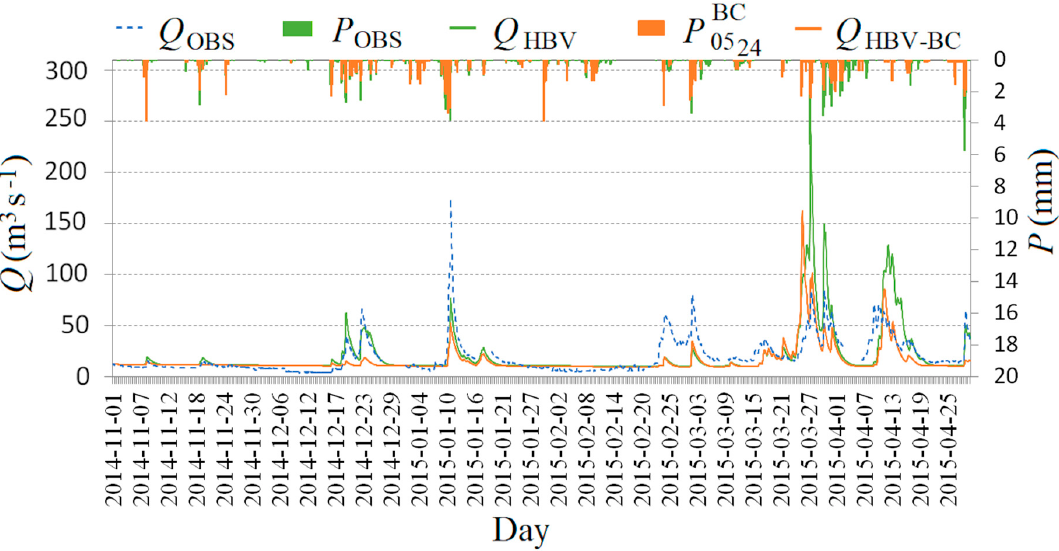
Figure 5. The comparison of Q OBS (observed flow; blue dotted line), Q HBV (HBV product for P OBS ; Figure 5. The comparison of 𝑄 (cid:2899)(cid:2886)(cid:2903) (observed flow; blue dotted line), 𝑄 (cid:2892)(cid:2886)(cid:2906) (HBV product for 𝑃 (cid:2899)(cid:2886)(cid:2903) ; green solid line), Q HBV − BC (HBV product for P BC without assimilation; solid orange line), and P OBS (cid:2886)(cid:2887) without assimilation; solid orange line), and 𝑃 05 24 green solid line), 𝑄 (cid:2892)(cid:2886)(cid:2906)(cid:2879)(cid:2886)(cid:2887) (HBV product for 𝑃 (cid:2868)(cid:2873) Figure 5. The comparison of 𝑄 (cid:2899)(cid:2886)(cid:2903) (observed flow; blue dotted line), 𝑄 (cid:2892)(cid:2886)(cid:2906) (HBV product for 𝑃 (cid:2899)(cid:2886)(cid:2903) ; (cid:3118)(cid:3120) (green bar), with P BC (orange bar) in the Sola basin at Zywiec in the winter period from 06:00H 1 (cid:2886)(cid:2887) (orange bar) in the Sola basin at Zywiec in the winter period from 06:00H 1 05 24 (green bar), with 𝑃 (cid:2868)(cid:2873) (cid:2886)(cid:2887) without assimilation; solid orange line), and 𝑃 green solid line), 𝑄 (cid:2892)(cid:2886)(cid:2906)(cid:2879)(cid:2886)(cid:2887) (HBV product for 𝑃 (cid:2868)(cid:2873) (cid:3118)(cid:3120) November 2014 to 23:00H 30 April (cid:3118)(cid:3120) November 2014 to 23:00H 30 April 2015. (cid:2886)(cid:2887) (orange bar) in the Sola basin at Zywiec in the winter period from 06:00H 1 (green bar), with 𝑃 (cid:2868)(cid:2873) (cid:3118)(cid:3120) November 2014 to 23:00H 30 April 2015.